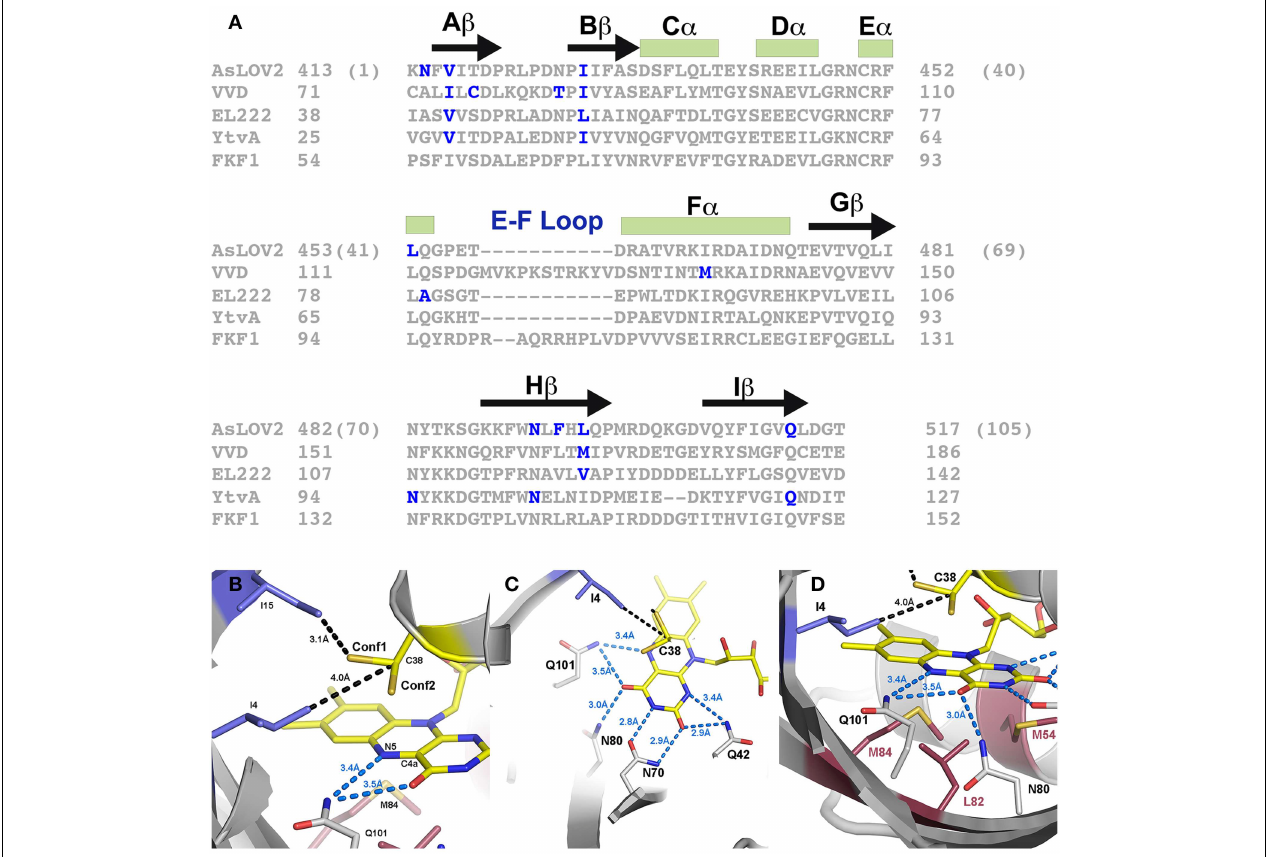
above the C4a position, where it is poised for C4a adduct formation. I4 juts in between the two conformations placing its methyl group only 4.0 Å away from C β . Rotation between the two conformations would require movement of I4. (C) A network of H-bonds in the pyrimidine ring stabilize the C4a adduct through electron withdrawing effects. (D) Full active site containing residues attenuating Conf1/2 (blue), residues at the re-face (red) and H-bonding residues (gray). Three residues, M54, L82, and M84 attenuate adduct decay pathways through steric and electronic regulation of the